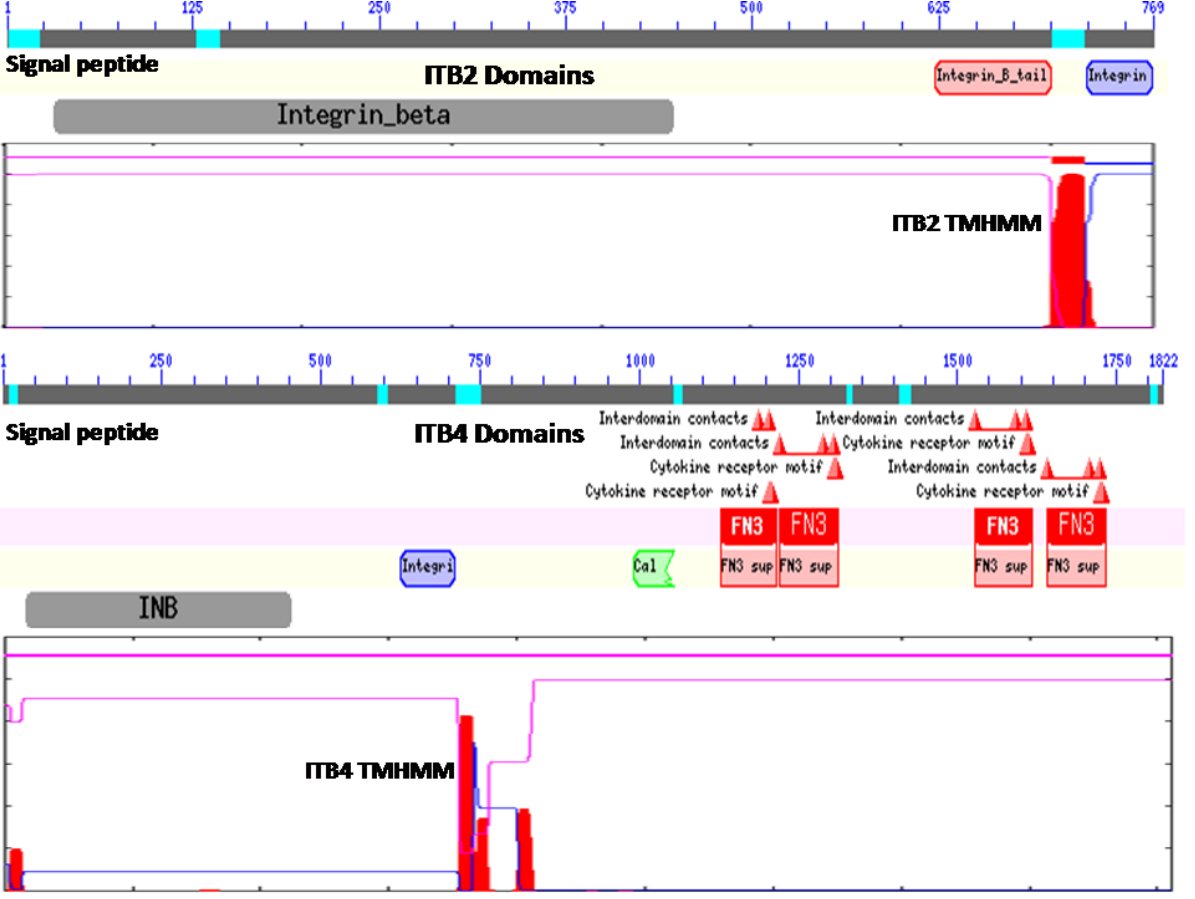
Figure 1. Predicted domains and transmembrane helix for human ITB2 and ITB4. Domains and key regions are identified for ITB2 and ITB4 amino acid sequences using NCBI web tools (http://www.ncbi.nlm.nih.gov/Structure/cdd/wrpsb.cgi) to identify functional domains and ExPasy web tools to identify predicted transmembrane domains (TMHMM) (http://www.cbs.dtu.dk/services/TMHMM-2.0/); INB or integrin_beta; integrin B tail (in pink); TMHMM transmembranes (in red); cytosolic domain (in blue); Calx-beta domain (in green); FN3 (fibronectin 3), cytokine receptor and interdomain contacts (red triangles); Note: lack of FN3 binding domains and the cytokine receptor motifs in  4 subunit that interacts only with